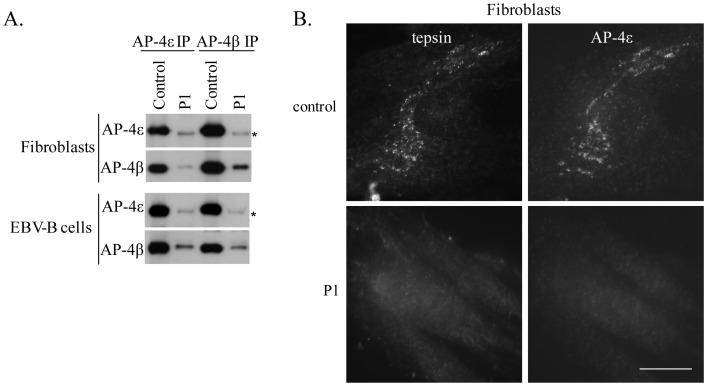
Immunoprecipitation and immunofluorescence of the AP-4 complex in P1.A). EBV-B cells and SV40 fibroblasts from P1 and a healthy control were subjected to immunoprecipitation under native conditions with antibodies against AP-4ε or AP-4β, and the immunoprecipitates were then western blotted with antibodies against AP-4ε or AP-4β. Equal amounts of protein were used for immunoprecipitation from patient and control cells. A small amount of AP-4β is coassembled with AP-4ε, and the AP-4ε assembled with AP-4β in P1 appears to be slightly smaller (AP-4ε*) than the AP-4ε in control cells. B). Fibroblasts from P1 and a healthy control were double-labeled for AP-4ε and the AP-4-associated protein tepsin. Note the specific loss of AP-4ε and tepsin from the cells of P1. Bar 20 µm. These experiments were carried out at least three times.